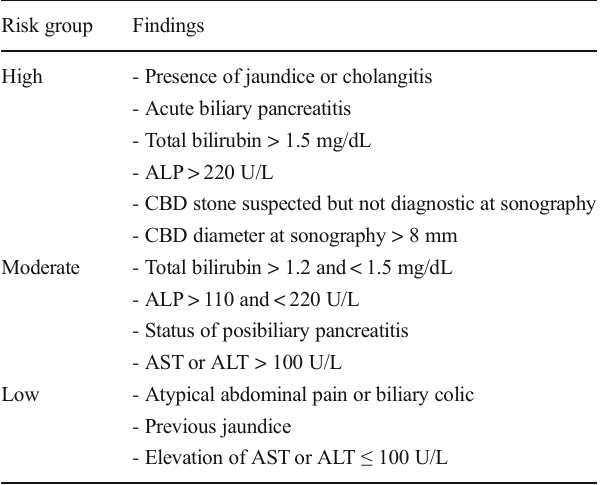
Classification ofclinical risk group according to laboratory and sonographic findings [8] Risk